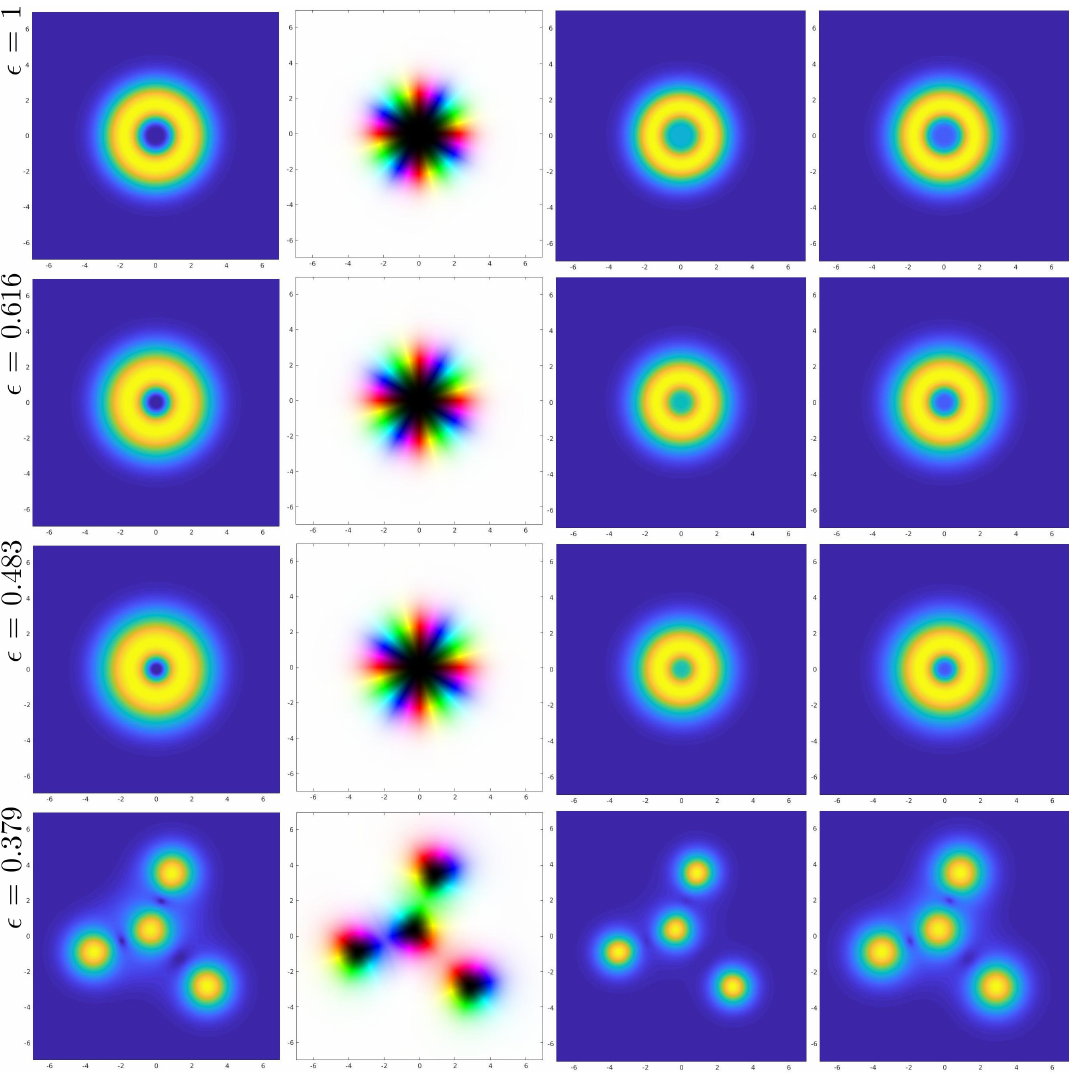
Figure 6. The Q = N = 4 baby Skyrmion for various values of (cid:15) . The columns show the topological charge density, the pion vector orientation using a color scheme described in the text, the total energy density and the perturbation energy density (cid:15) ( −L (cid:15) = 0 . 379 ) shows that the solution has decayed into a lower-energy configuration with almost- triangular symmetry instead of axial symmetry. In this figure m